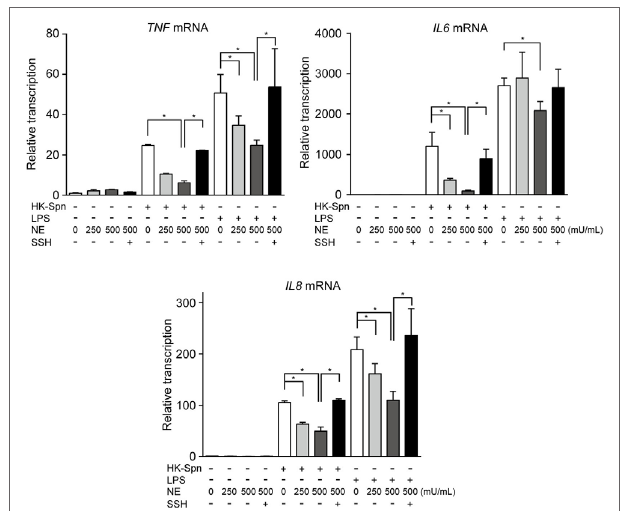
FigUre 1 | Neutrophil elastase (NE) downregulates cytokine gene transcription in macrophages stimulated with TLR agonists. THP-1-derived macrophages were stimulated with HK-Spn D39 or Escherichia coli LPS (100 ng/mL) in the presence or absence of hNE (250–500 mU/mL) and/or SSH (100 µg/mL) for 4 h under serum-free conditions. Real-time PCR was performed to quantify TNF , IL6 , and IL8 mRNA in the macrophages exposed to these stimuli. The relative quantity of these cytokine mRNAs was normalized to the relative quantity of GAPDH mRNA. Data represent the mean ± SD of quadruplicate experiments and were evaluated using one-way analysis of variance with Tukey’s multiple-comparisons test. *Significantly different within the same activation status at P < 0.05. HK-Spn, heat-killed S. pneumoniae ; LPS, lipopolysaccharide; hNE, human neutrophil elastase; SSH, sivelestat sodium hydrate; TLR, toll-like receptor; TNF, tumor necrosis